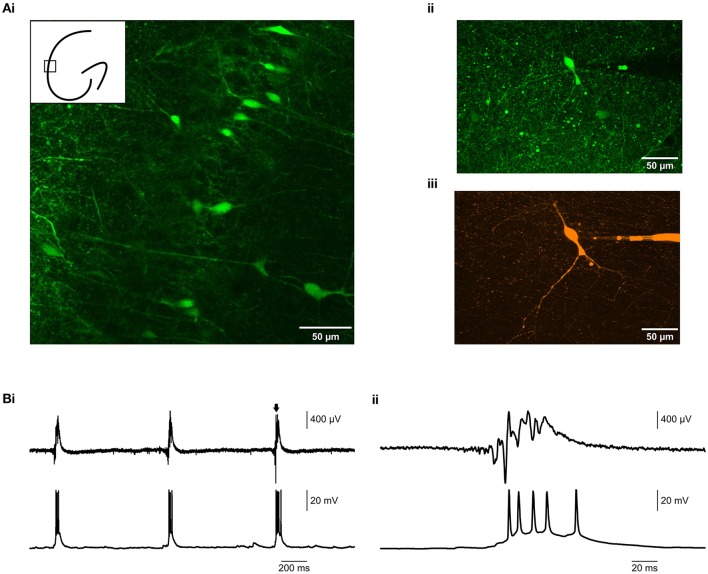
Simultaneous visually-guided patch clamp and field recording in 9 mM K+. (Ai) 20 × image of a brain slice from a VGAT-Venus A rat (Uematsu et al., 2008), showing fluorescently labeled interneurons in hippocampal CA1. The inset cartoon roughly shows the imaged region. (Aii) 40x image of an individually targeted interneuron in hippocampal CA3b. (Aiii) The same interneuron, filled with 200 nM Alexa 647 hydrazide for improved visualization. (B) Epileptiform activity (LFP, upper traces) was induced by 9 mM K+, whilst simultaneously recording the firing of a targeted interneuron in current clamp mode (lower traces).(Bii) is an expanded view of the burst indicated by the arrow in (Bi).